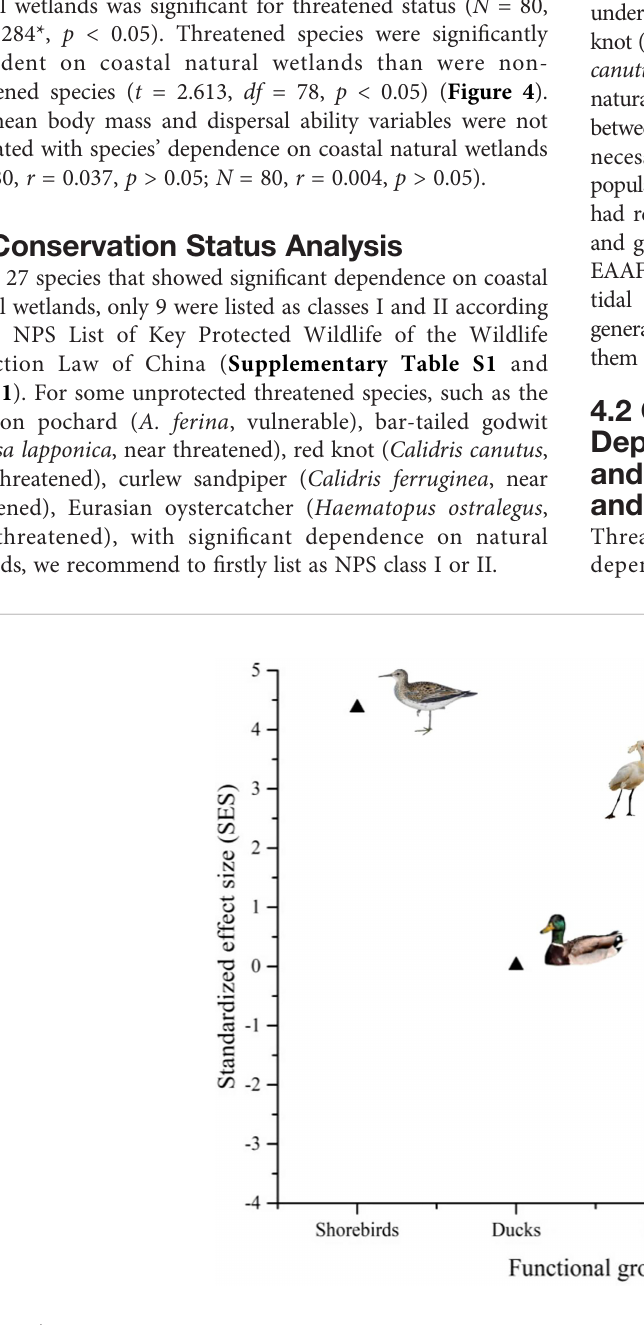
FIGURE 3 | Dependence of waterbird species on coastal natural wetlands and the standardized effect size (SES) of the four functional